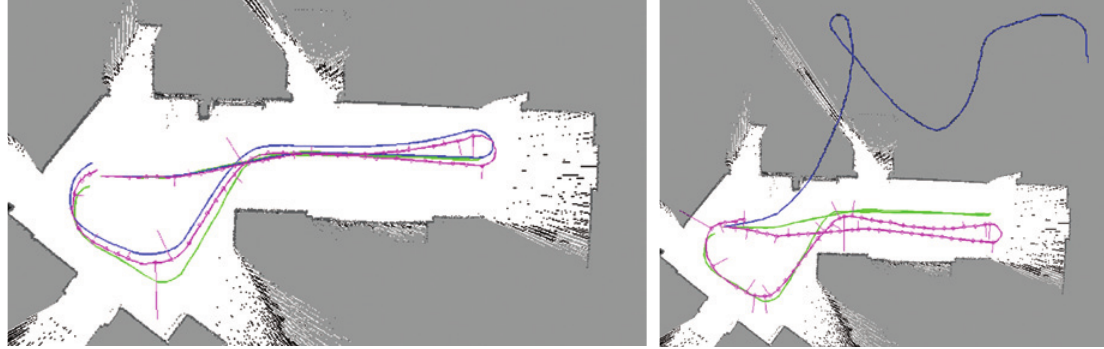
Figure 16. Two Examples of Vision-Based Path Following Using the Same Map (in Green). Raw odometry is in blue; replayed trajectory is in magenta. Left: Path following using the pioneer 3DX odometry. Right: Path following using simulated noise of 6 σ